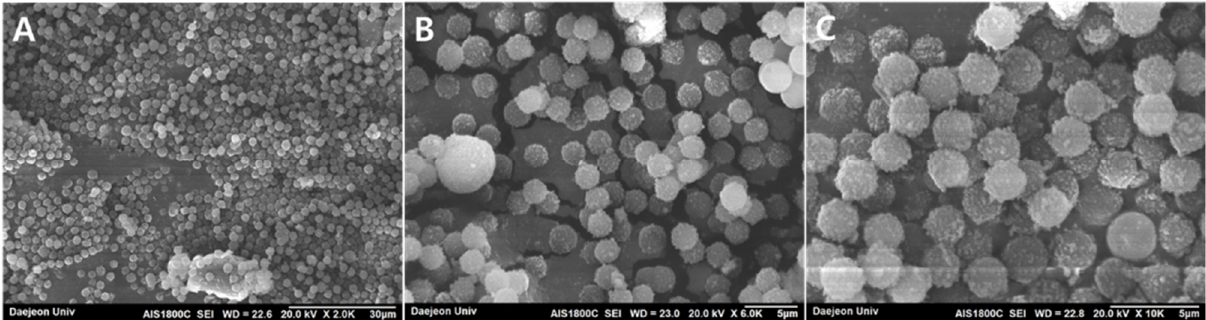
Figure 3. SEM images of microparticles of the top portion of PEG-DEX ATPS after the EDC coupling reaction with different magnifications. ( A ) 2000 times, ( B ) 6000 times, ( C ) 10,000 times magnified. Scale bars are ( A ) 30, ( B ) 5, ( C ) 5 μm. See Experimental for other conditions.